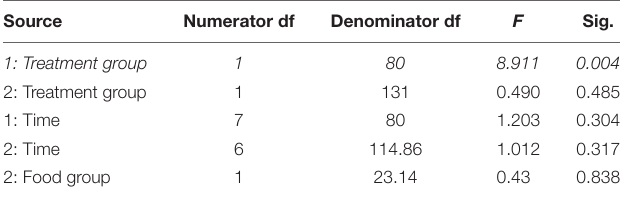
TABLE 3 | Fixed effects from the linear mixed effects model of total body mass in study 1 (indicated by 1) and study 2 (2) between treatment groups, food groups and across time.